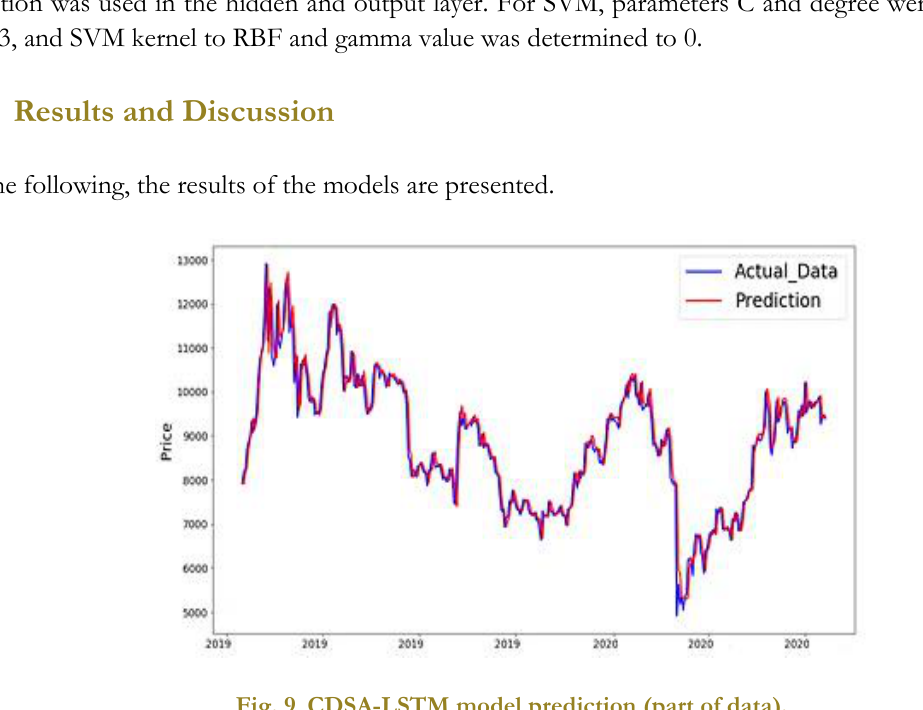
Fig. 9 . CDSA-LSTM model prediction (part of